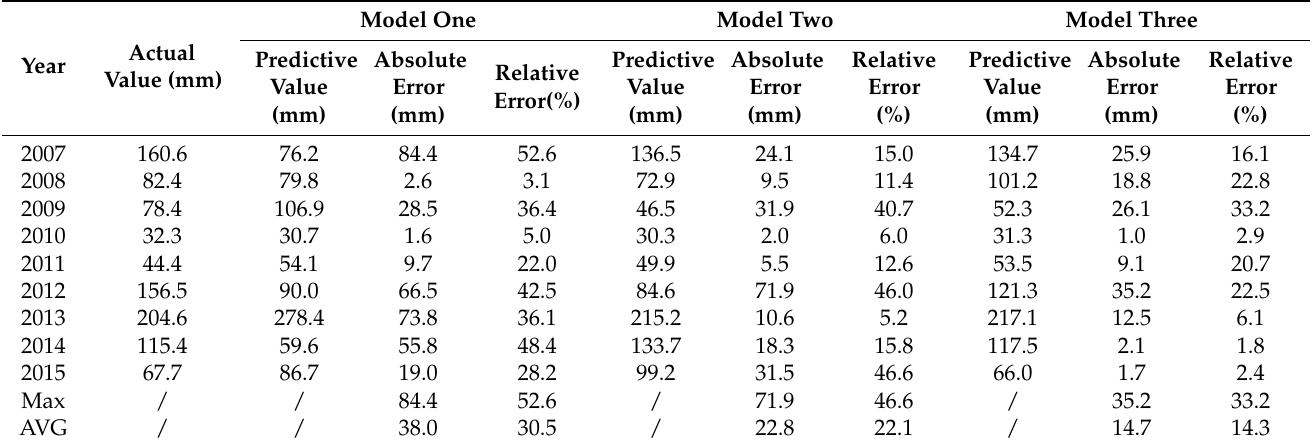
Table 4. Predicted summer typhoon precipitation amount in typhoon affecting